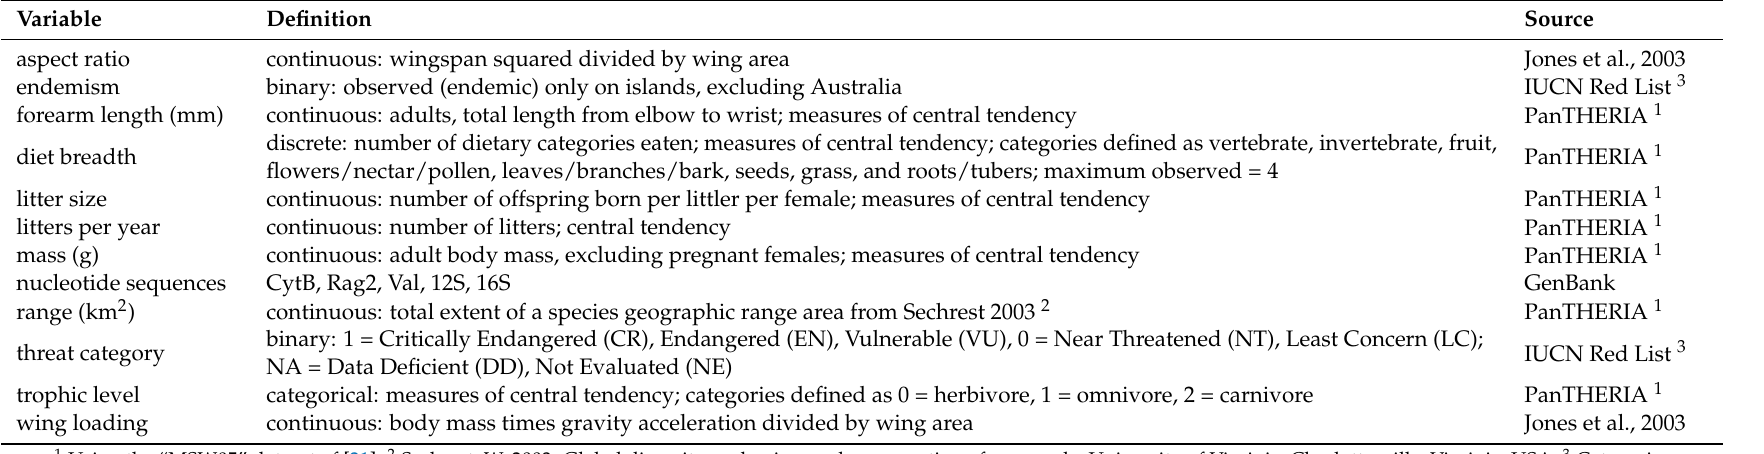
Table 1. Summary of data sources used in a global phylogenetic assessment of extinction risk for bat species